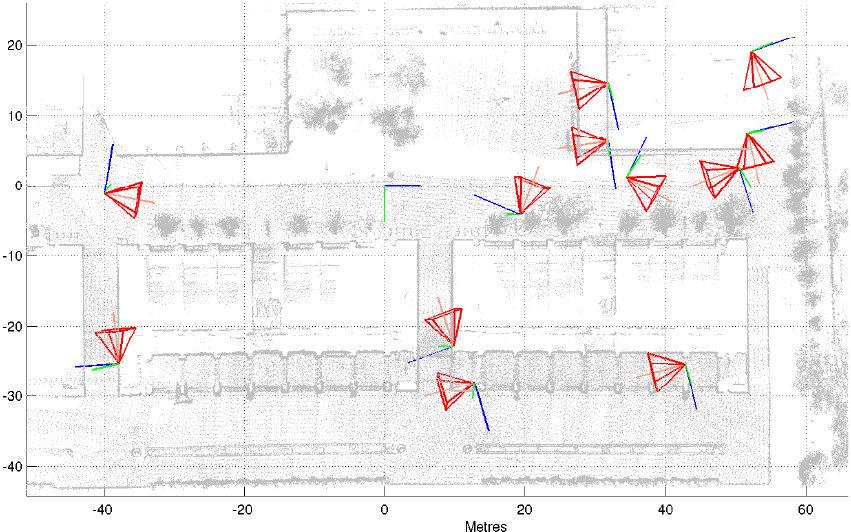
Figure 10. Calibrated camera locations for the Barcelona Robot Lab (BRL) dataset.